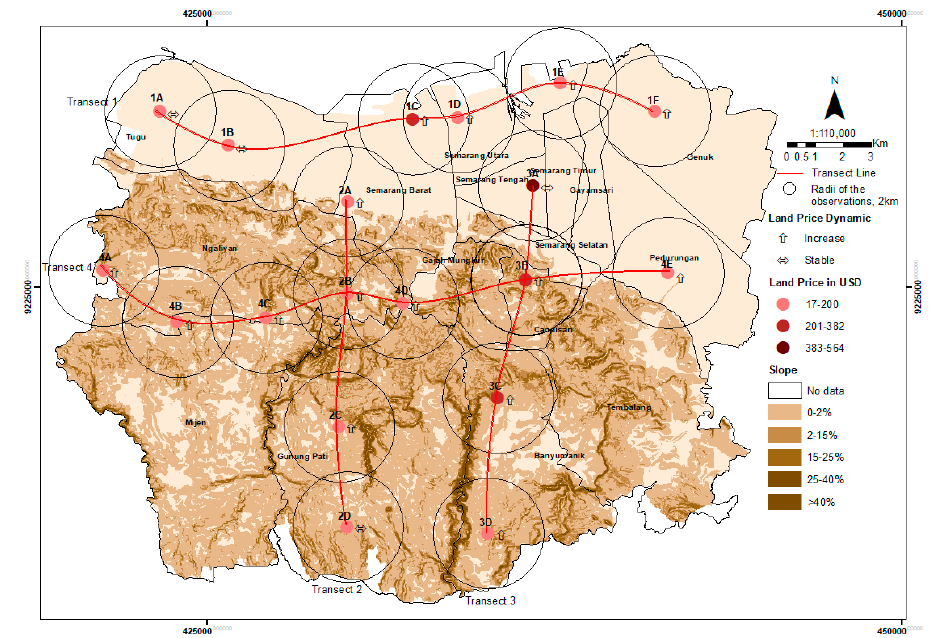
Figure 3. Land values and their dynamics.